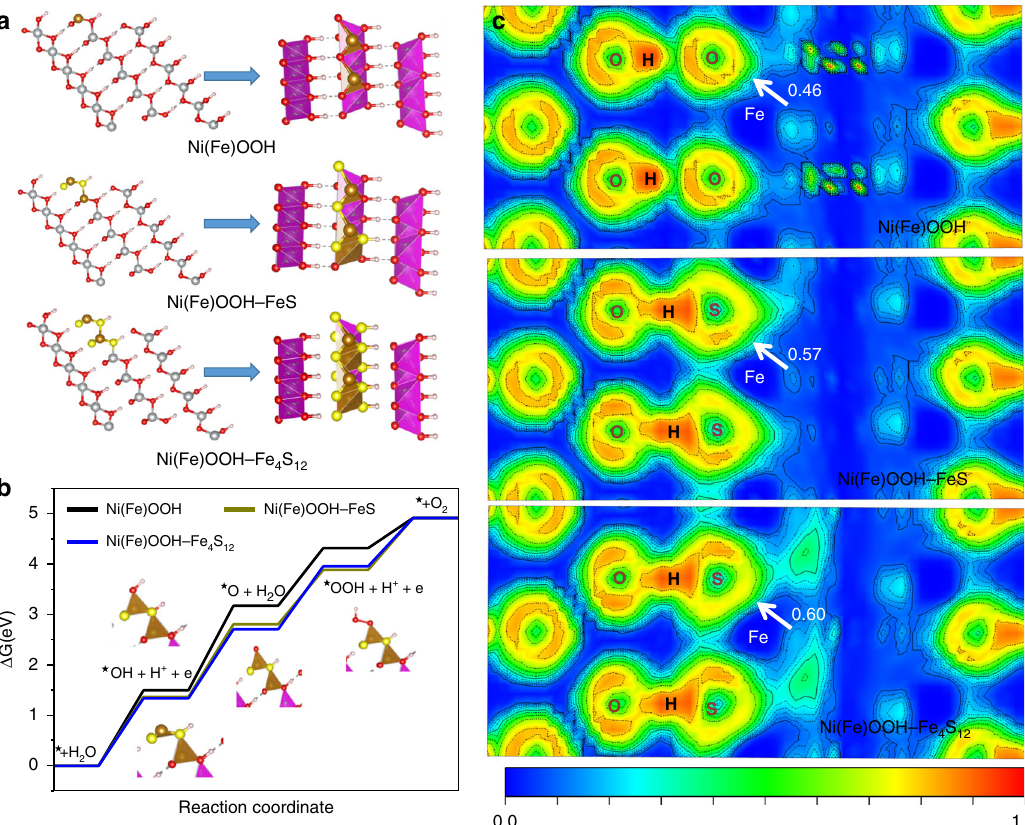
Fig. 6 DFT calculations. a Structural model, b free energy diagram, c electron localization